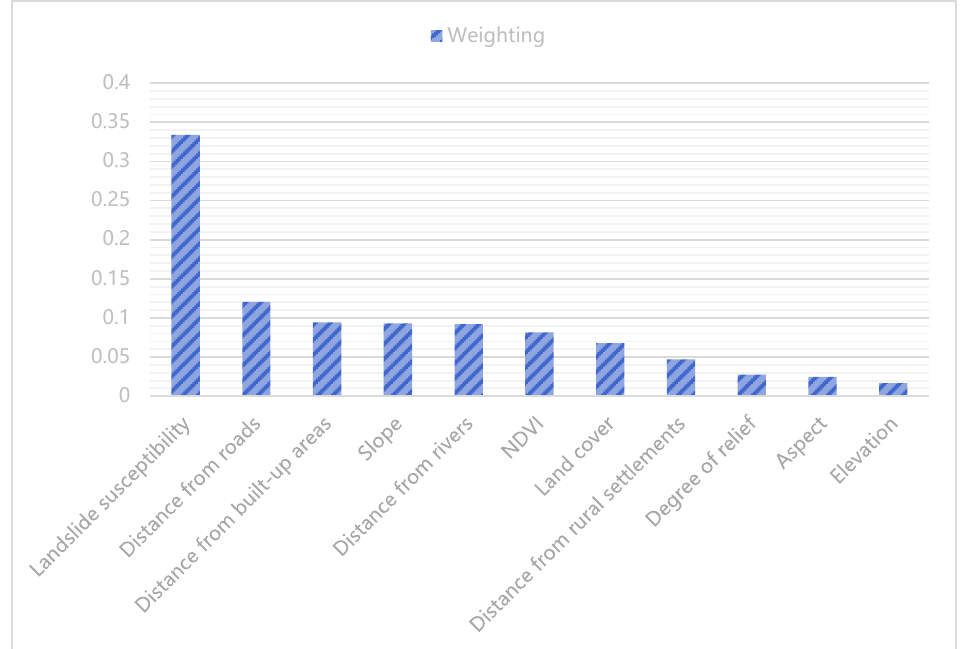
Figure 7. Ranking the importance of factors influencing the suitability of construction.